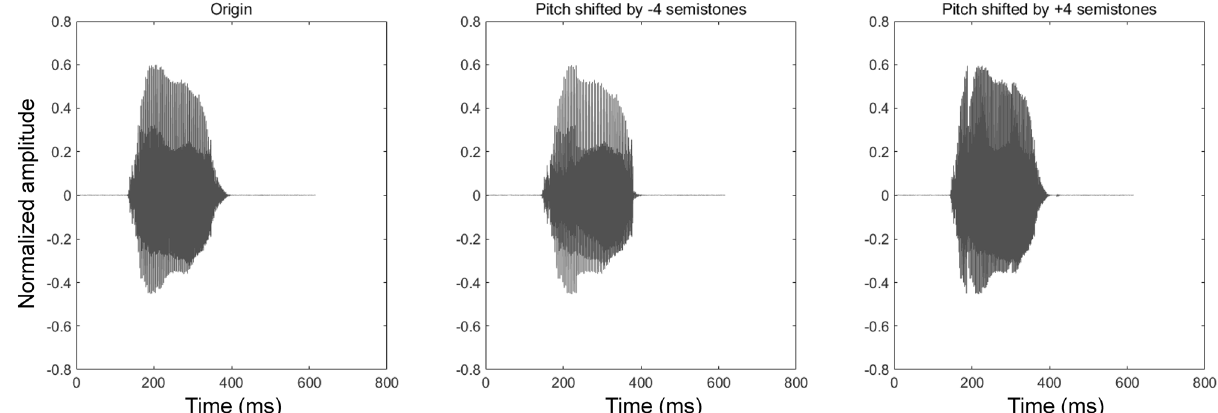
Figure 2. Examples of a voice speaking “ah” with and without pitch-shifting. Y-axes are normalized amplitude ranging from − 1 to + 1, corresponding to the minimum and maximal voltage that can be produced by the line driver,